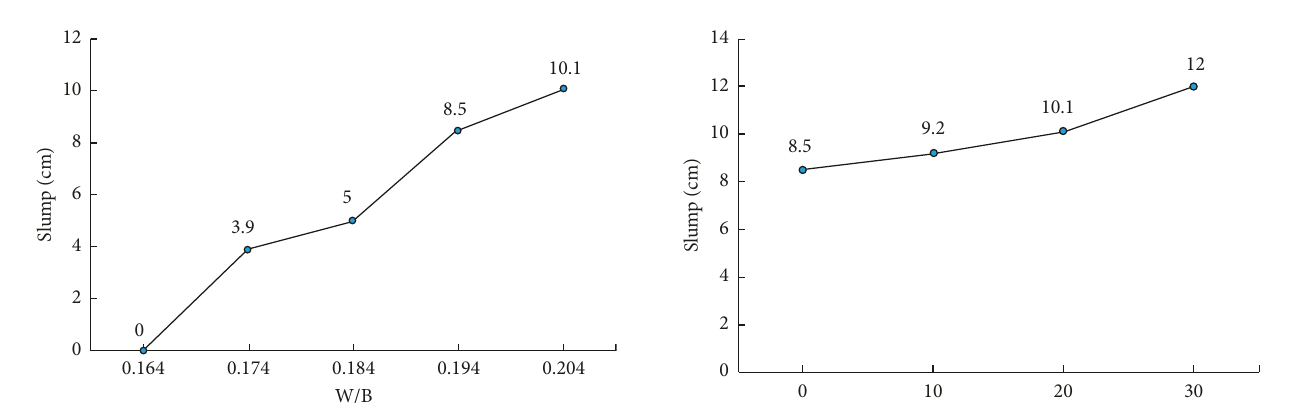
Figure 4: Influence of the W/B ratio on the slump of